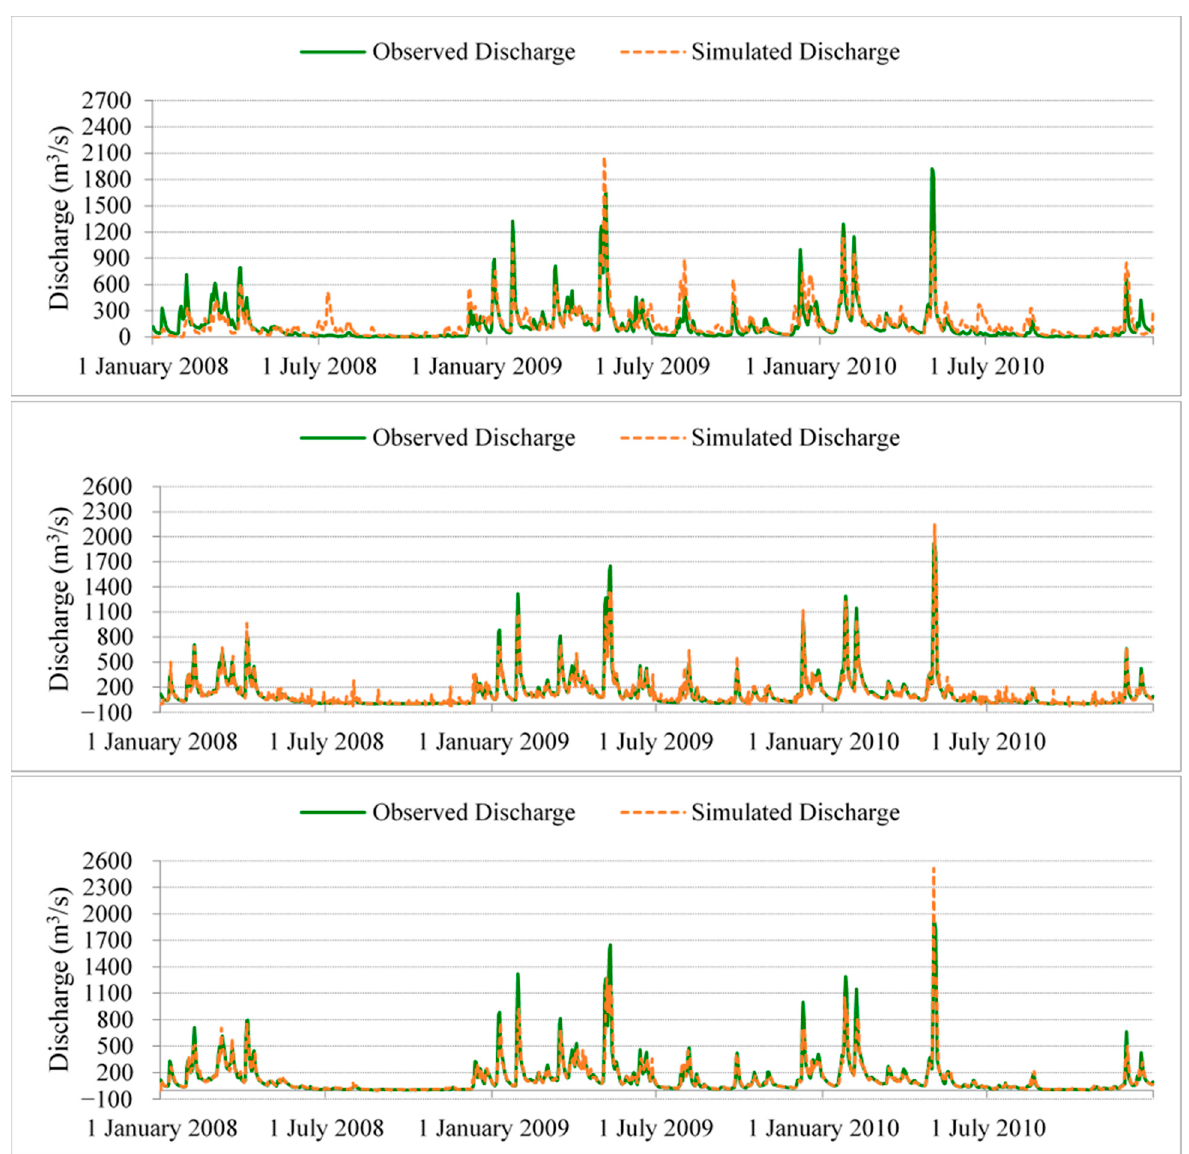
Figure 11. Daily discharge validation for SWAT ( top ), ARX ( middle ), and GEP ( bottom ) at LD10 for time period 2008–2010.